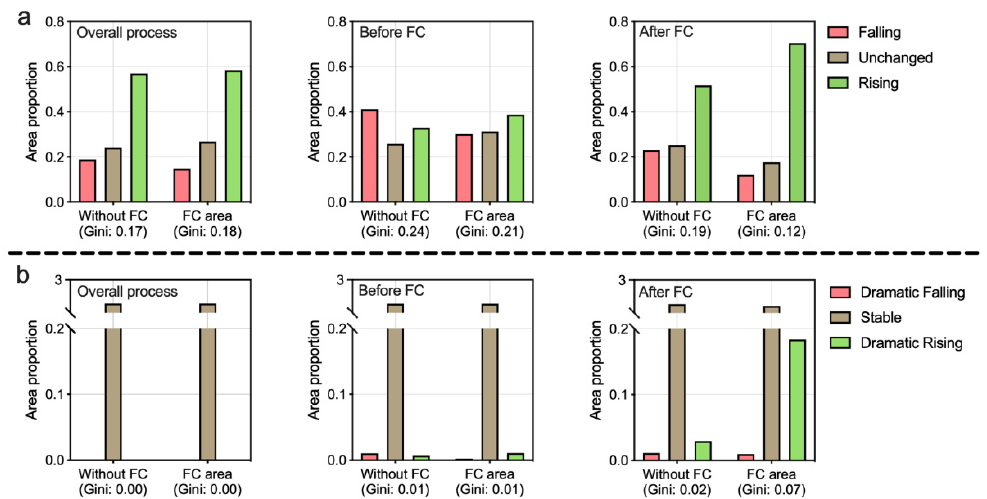
Figure 9. The comparison between FC areas and the plots without FC based on Kendall’s τ value ( a ); the comparison between FC areas and the plots without FC based on Theil–Sen slope ( b ). The Gini coefficients are shown along the scale of the x ‐ axis.